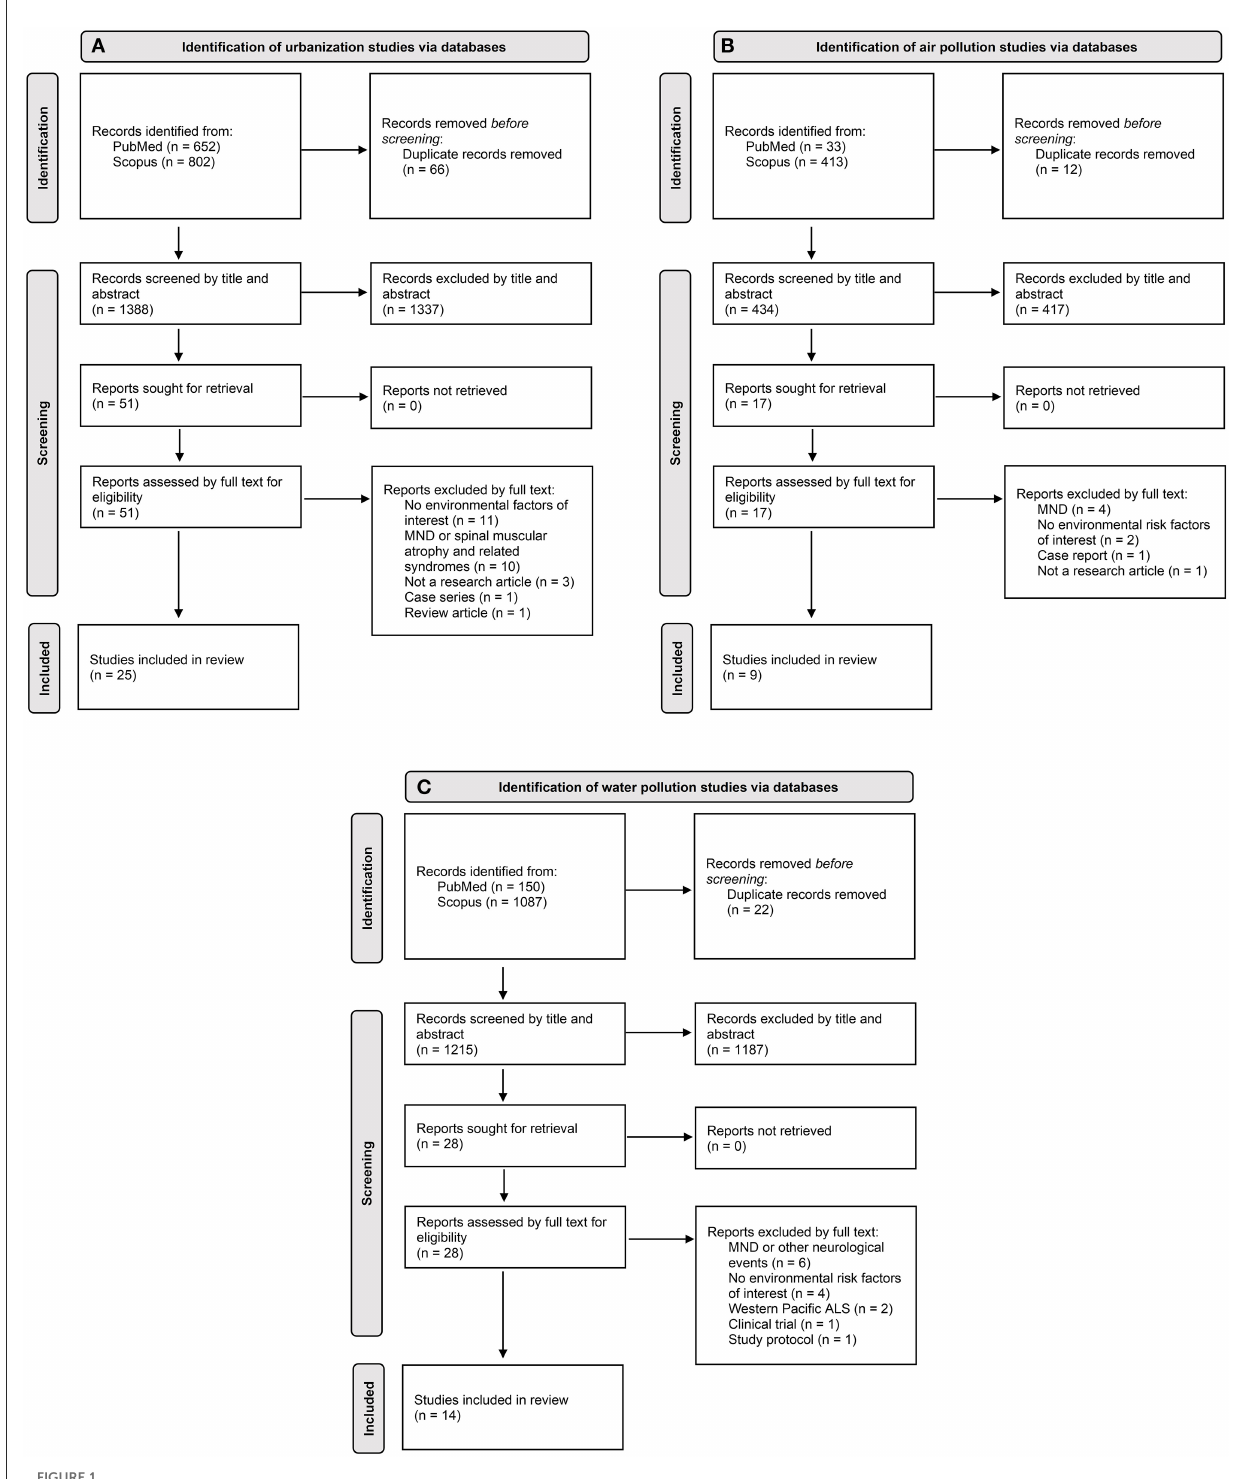
FIGURE1 PRISMA (31) flowchart of study selection for each exposure of interest: (A) urbanization; (B) air pollution; (C) water pollution. Flow of information charts showing the number of unknown records identified through citation analysis on Scopus for each exposure of interest can be found in the Supplementary